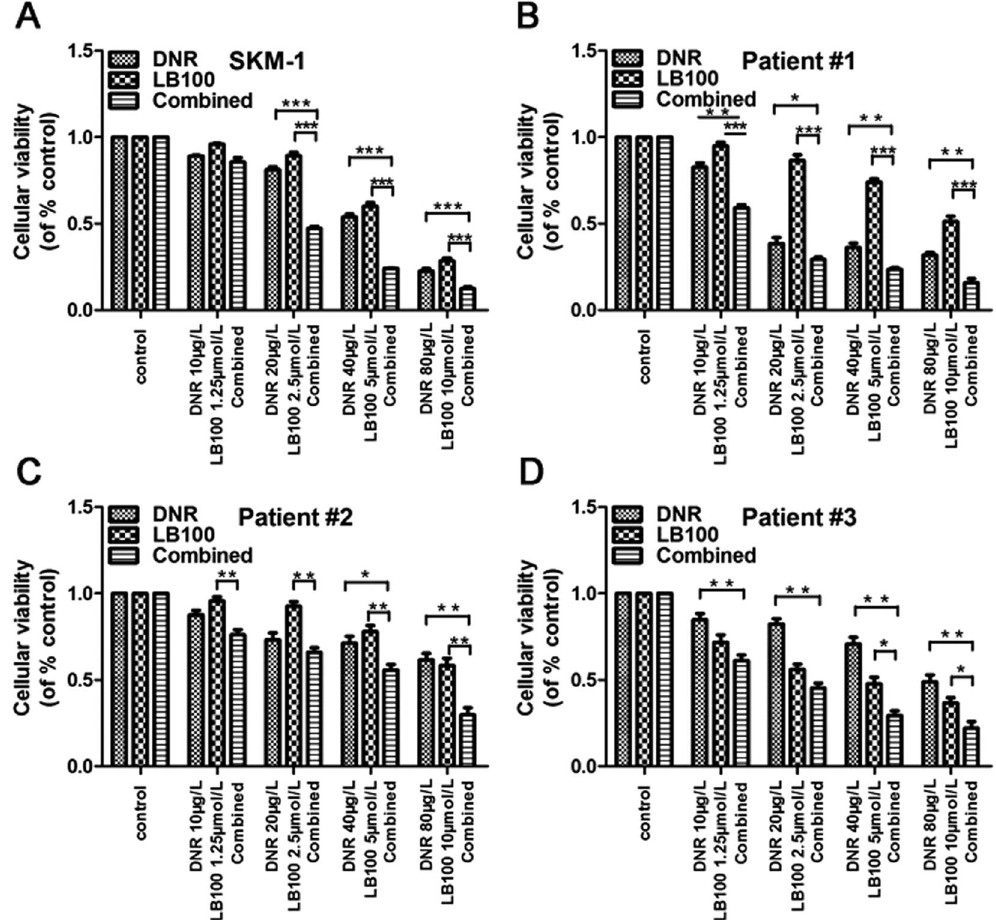
Figure 3. LB100 enhances daunorubicin cytotoxicity to sAML in vitro . ( A–D ) LB100 significantly enhanced the cytolytic activity of daunorubicin in SKM-1 cells, and in three primary sAML patient samples. Statistically significant differences are marked by an asterisk ( * P < 0.05; ** P < 0.01, *** P ≤